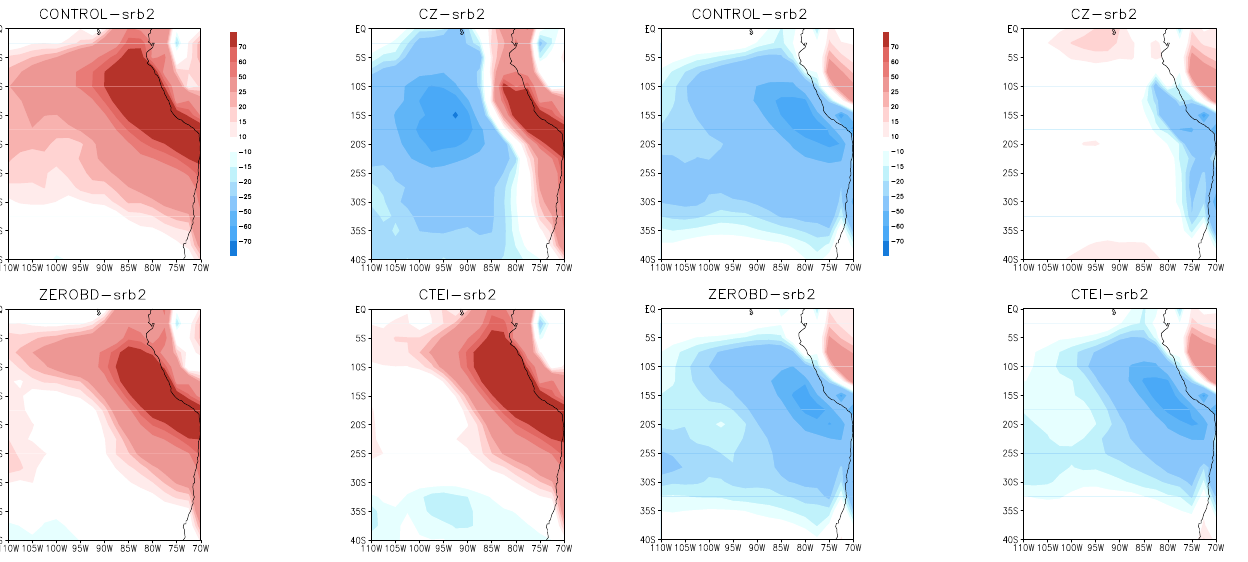
Fig. 7. As in Fig. 6 except for longwave radiative flux errors.